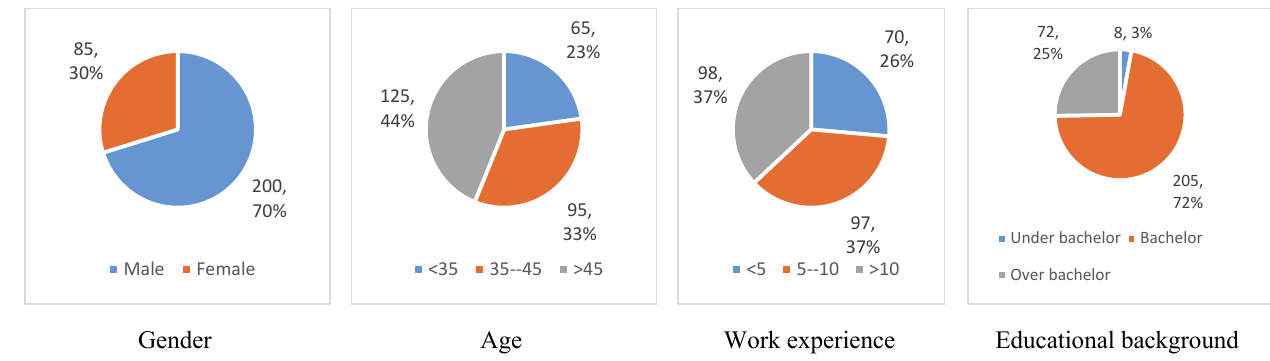
Fig. 1. Personal characteristics of the participants